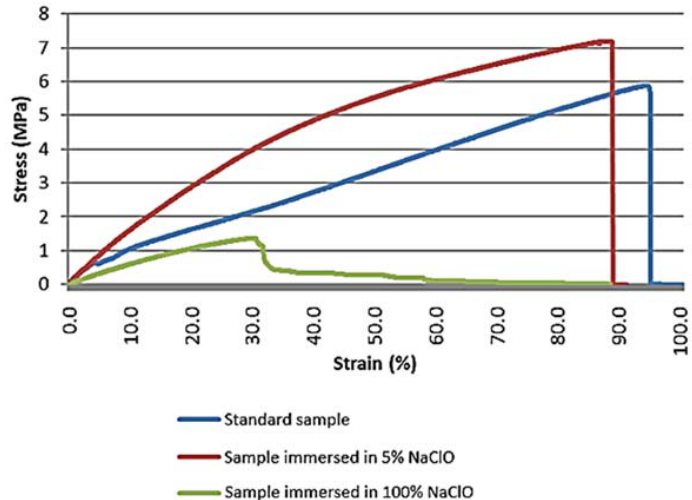
Figure 14. Stress-strain graph of the beech tensile test for the standard sample and samples immersed for three months in 5% and 100% NaClO